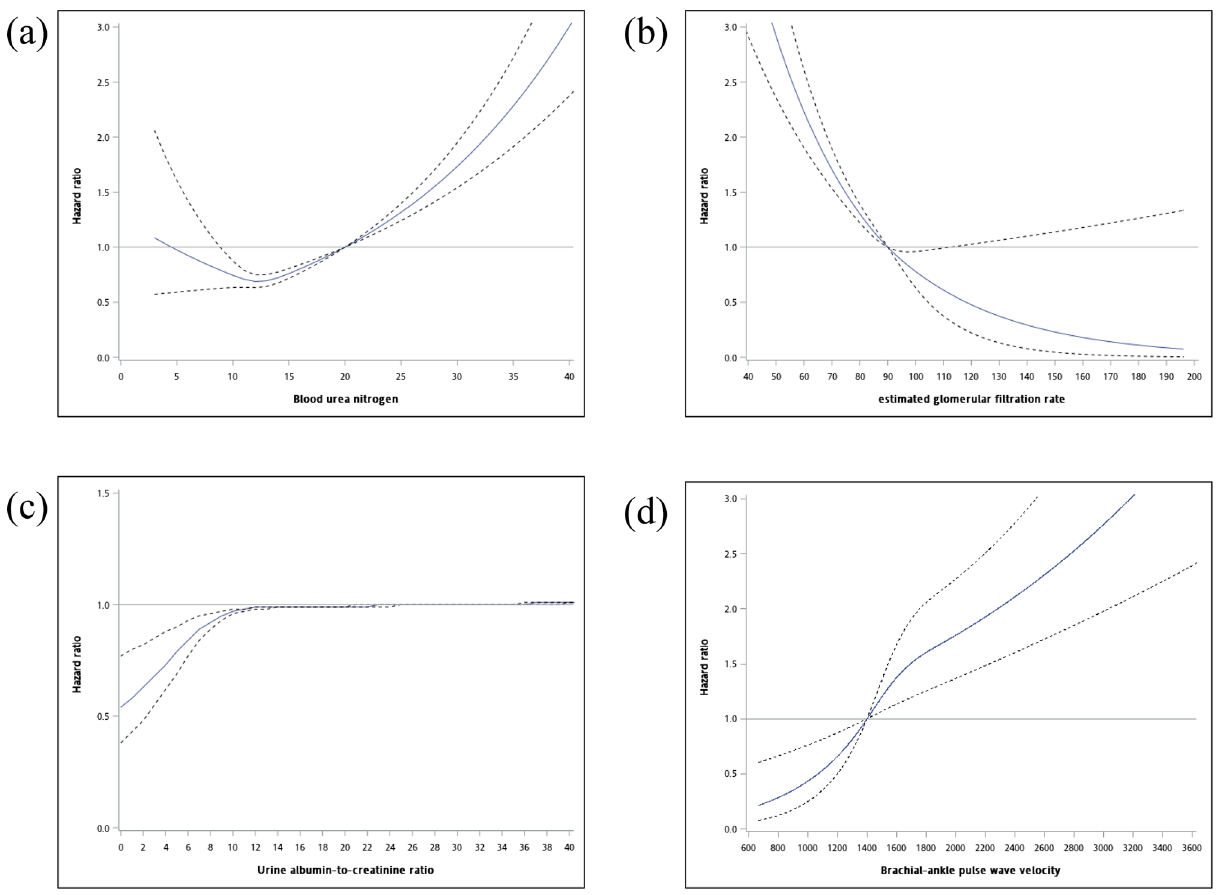
Figure 1. Restricted cubic spline model displaying the hazard ratios for all-cause mortality by ( a ) BUN, ( b ) eGFR, ( c ) urine ACR, and ( d )